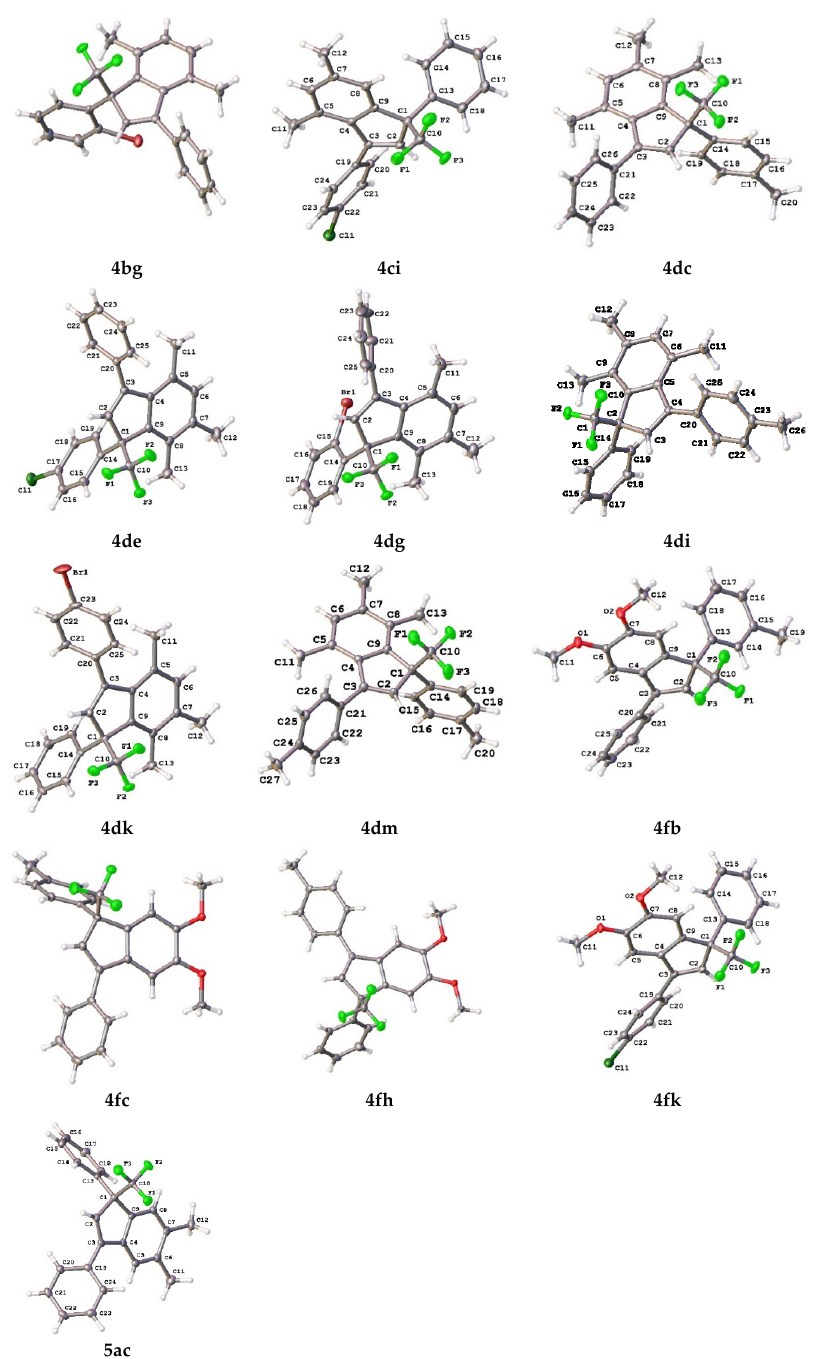
Figure 2. X-ray crystal structures of compounds 4bg (CCDC 1568593), 4ci (CCDC 1578216), 4dc (CCDC 1568602), 4de (CCDC 1568599), 4dg (CCDC 1568594), 4di (CCDC 1563374), 4dk (CCDC 1568596), 4dm (CCDC 1568600), 4fb (CCDC 1568595), 4fc (CCDC 1568597), 4fh (CCDC 1568603), 4fk (CCDC 1568598), and 5ac (CCDC 1568601) (ellipsoid contour of probability levels is 50%), Green sticks are fluorine atoms.